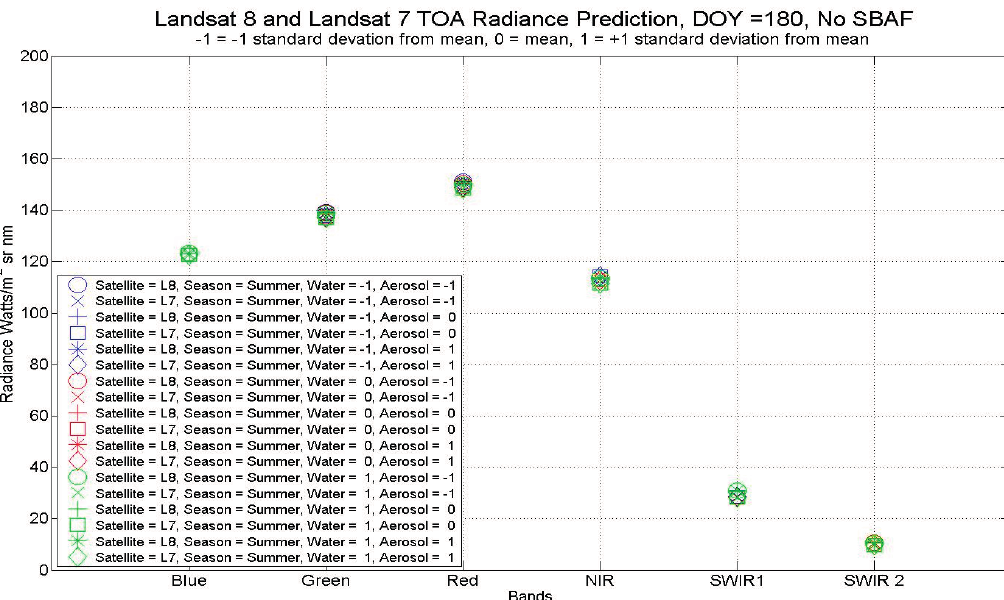
Figure 13. Radiance levels predicted for the Libya 4 test